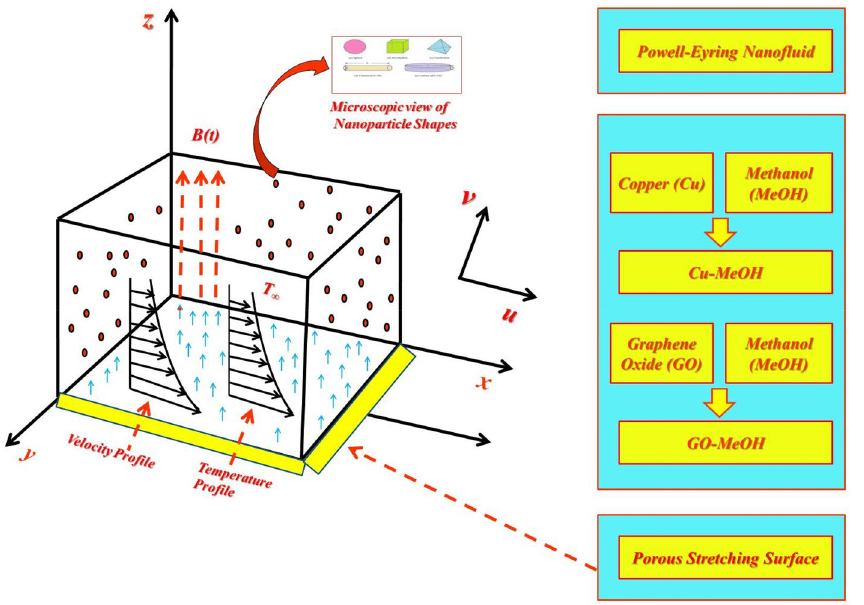
Figure 1. Graphic diagram of nanofluid